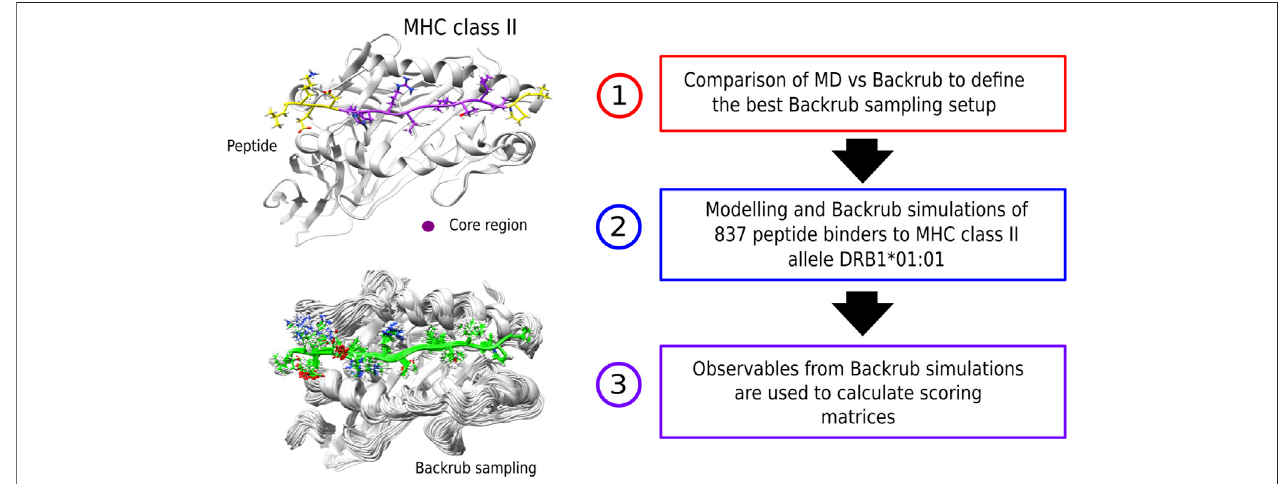
FIGURE 1 | (left) Examples of a peptide bound to an MHC class II receptor and conformations from the Backrub Rosetta simulations. (right) Schematic representationofthemethodologicalstepsthatinvolvecreationofthescoring-matrices.First,anMDvs.Backrubcomparisonwasperformedtode fi nethebestBackrub setup. Then, the modelling and sampling of a set of known peptide binders was performed to obtain the observables for building the